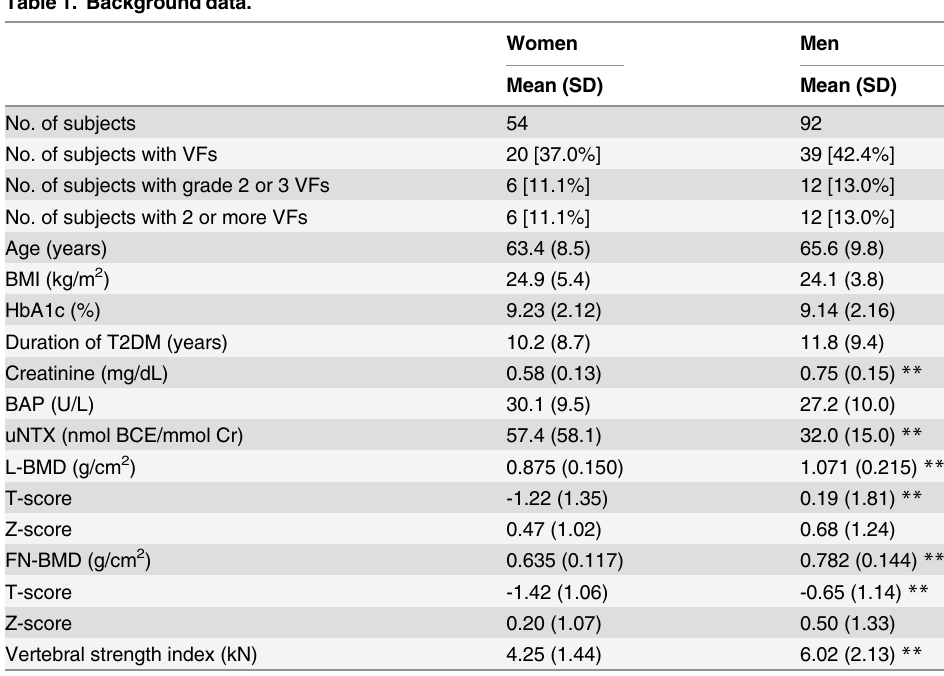
Table 1. Background